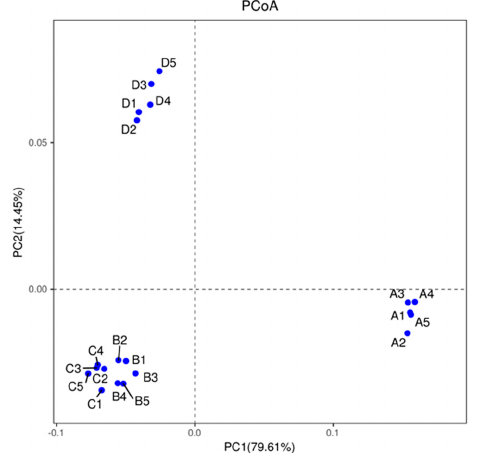
Figure 4. Comparison of the bacterial community structure in each treatment unit of the piggery’s wastewater purification system. Note: A: inlet; B: aerobic zone; C: anoxic zone; D: anaerobic